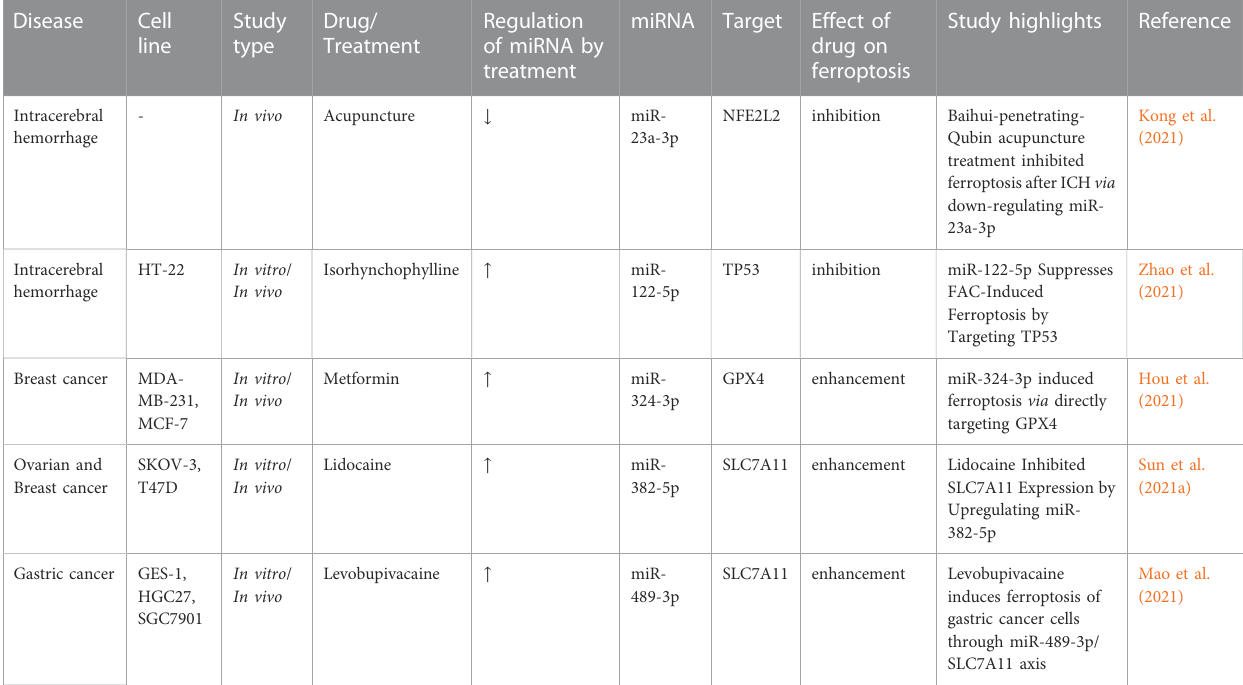
TABLE 3 Effects of drugs on ferroptosis-associated miRNAs.